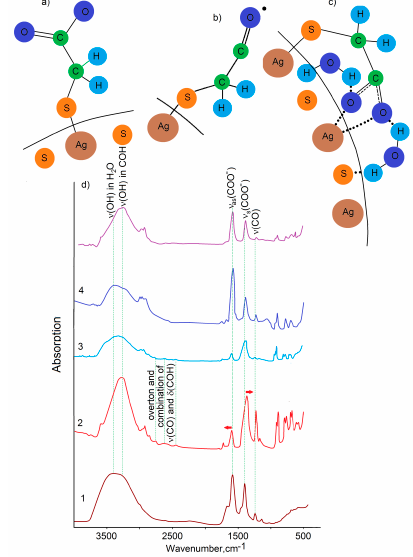
Figure 2. Scheme of interactions processes between TGA molecules and Ag 2 S QD surface (a, b and c). FTIR spectra of colloidal Ag 2 S/TGA QDs (d): 1 - TGA pH = 11; 2 - [AgNO 3 ]:[TGA]:[Na 2 S] = 1:0.9:0; 4 - [AgNO 3 ]:[TGA]:[Na 2 S] = 1:1.1:0.33 before exposure (2, 4) and after exposure (3,